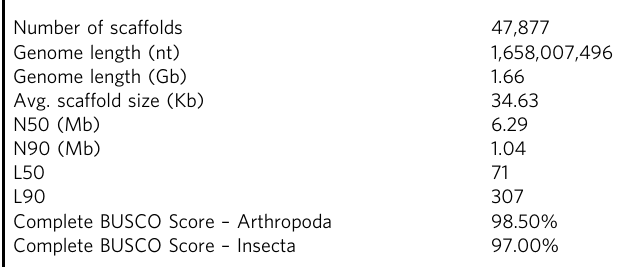
Table 1 Gryllus bimaculatus genome assembly